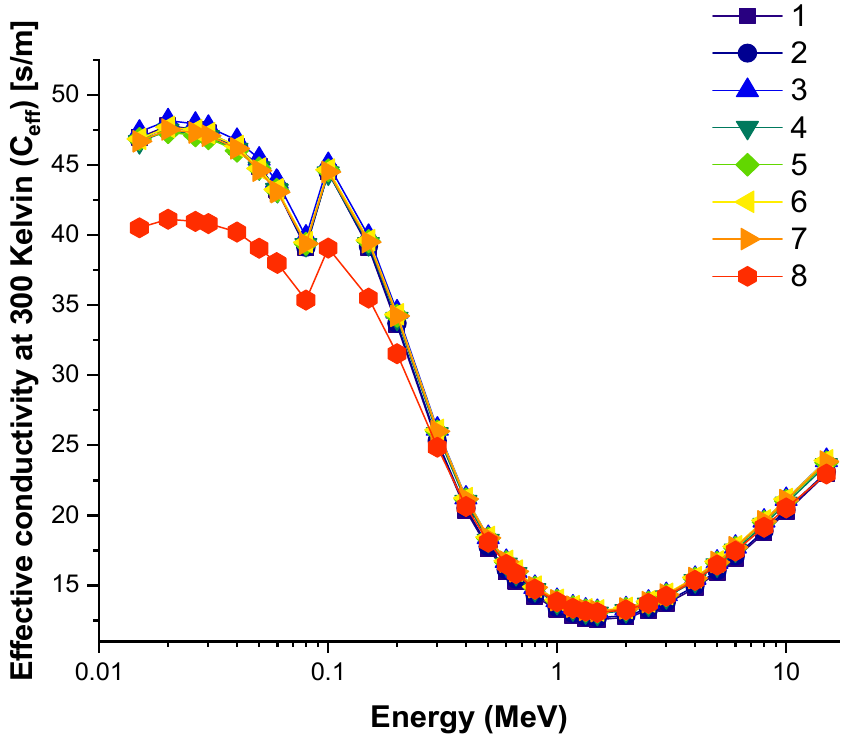
Figure 16. Variation of effective conductivity (C eff ) at 300K (s/m) for all glasses.